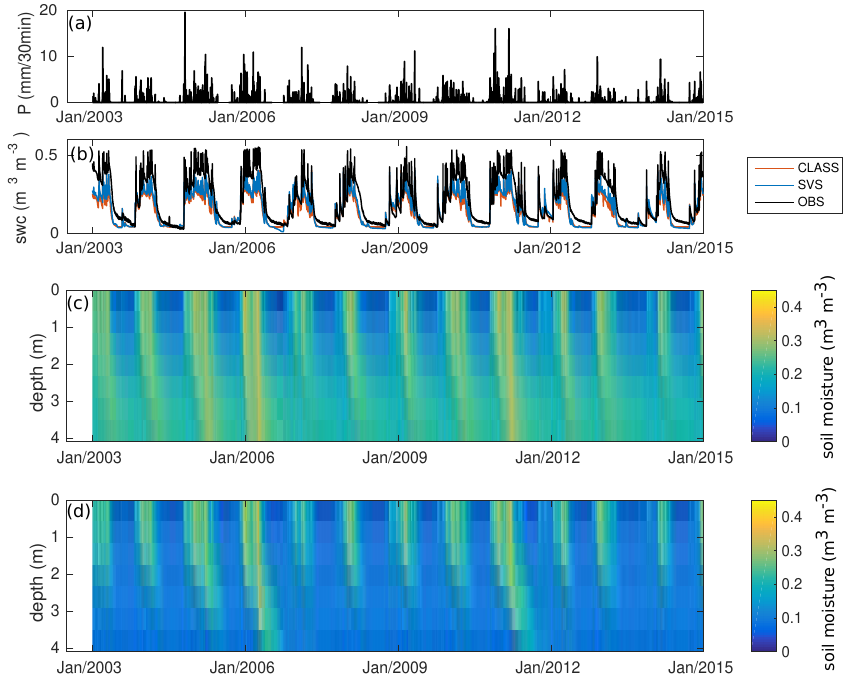
Figure 7. Precipitation (P) and soil water content (SWC) at 30-min time steps for the US-Ton Mediterranean site: ( a ) precipitation; ( b ) soil water content at the surface layer (0–10 cm) for observations (black lines), SVS simulations (blue line) and CLASS simulations (red line); and simulated soil water content profile for ( c ) SVS and ( d ) CLASS